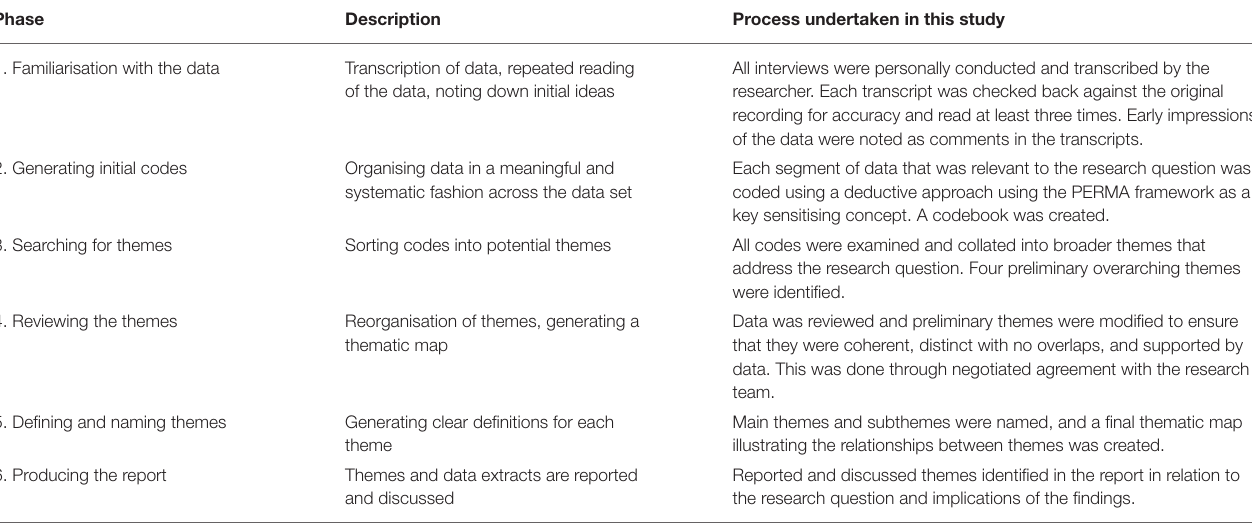
TABLE 2 | Braun and Clarke’s (60) six-phase framework for thematic analysis. Phase